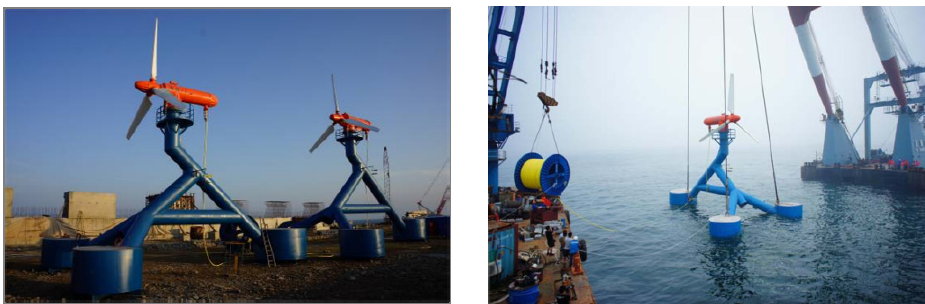
Figure 26. A 100 kW horizontal-axis TCPGSs. Reproduced from [4,29].